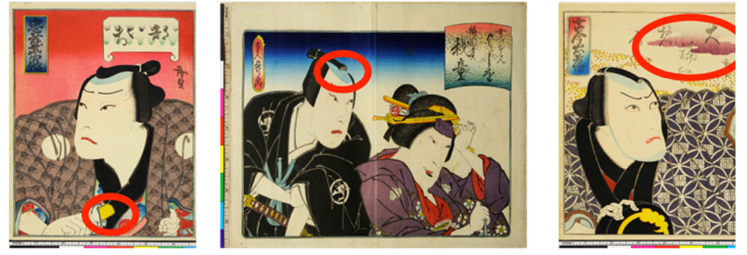
Figure 1. The example of rare and attractive colors in ukiyo-e prints are shown in red circles.